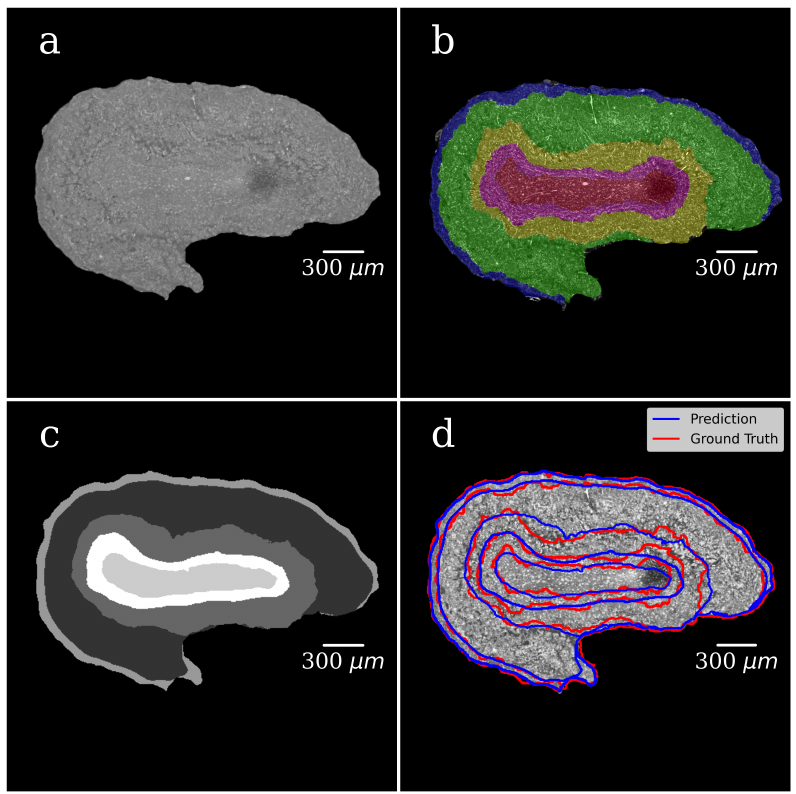
Figure 5. Multi-Class Segmentation. ( a ) Grayscale image of the OB tomographic slice; ( b ) multiclass mask manually annotated to segment OB anatomical layers, each color corresponds to one OB layer with a specific neural structure; ( c ) CNN generated multiclass ROI masks (the U-Net model). The grayscale of each mask corresponds to a specific OB layer; ( d ) grayscale slice image of the OB with the boundary of the OB layers outlined in red with ground-truth mask (manual segmentation) and in blue with CNN generated mask (the U-Net